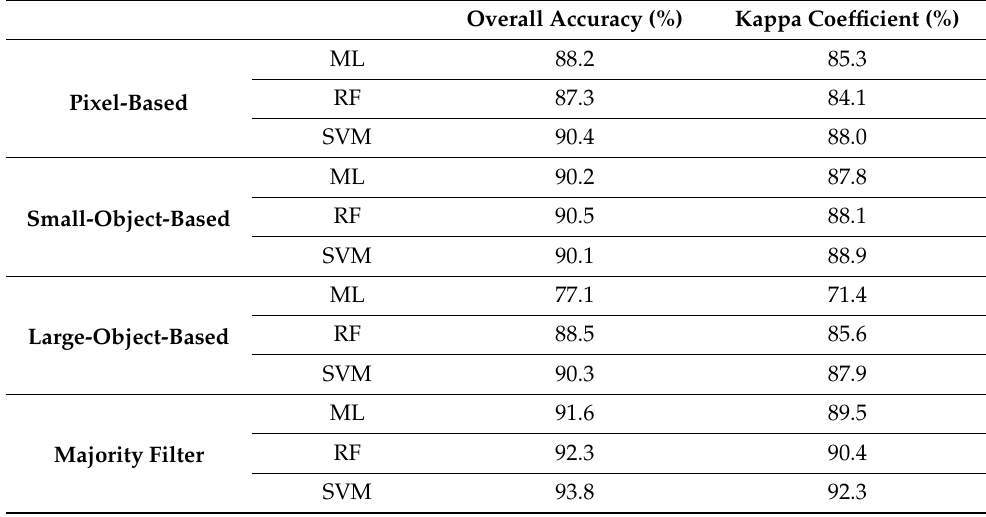
Table 2. Overall accuracies and kappa coefficients for the classical and traditional machine learn- ing